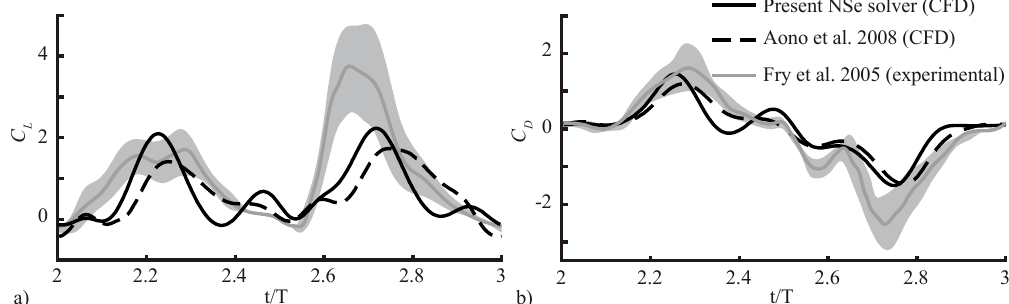
Figure A1. Comparison of fruit fly ( a ) lift coefficient C L and ( b ) drag coefficient C D between Fry et al. [43], Aono et al. [44], and the present NSe solver. Note that the gray shaded region around the gray trace bounds the upper and lower force values for the experimental results of Fry et al. [43].